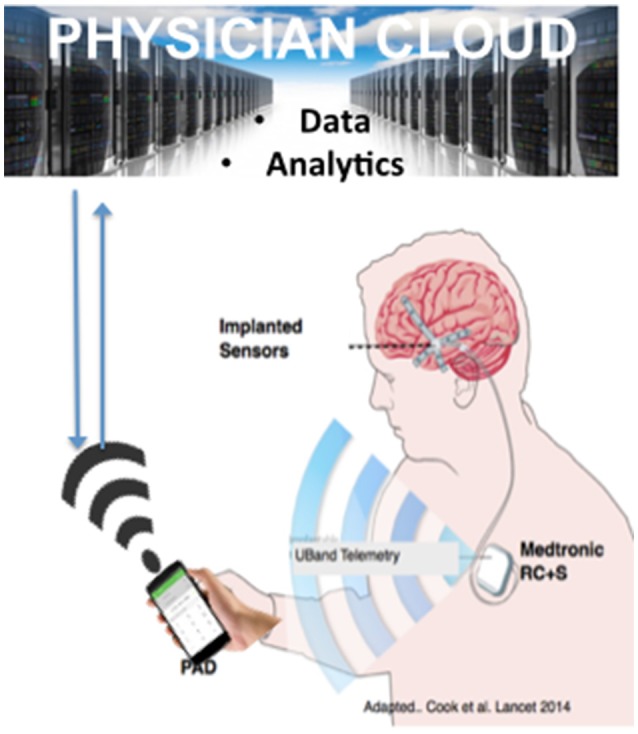
Next Generation Epilepsy Therapy Platform. The implanted, rechargeable Medtronic RC+S provides bi-directional coupling with the brain in patients with epilepsy. The personal assistant device (PAD) provides off-the-body analytics and is bi-directional with a cloud environment. The figure is adapted from Cook et al. with permission (Cook et al., 2013 with permission).